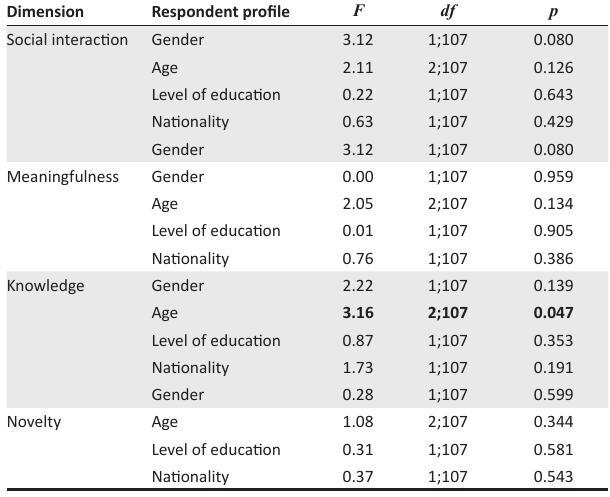
TABLE 5: Differences in perceptions of cognitive dimensions based on demographics: Shark-diving.